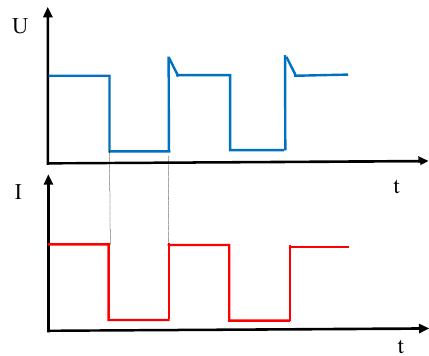
Figure 1. Variations of voltage and current with time during cold metal transfer (CMT) process.